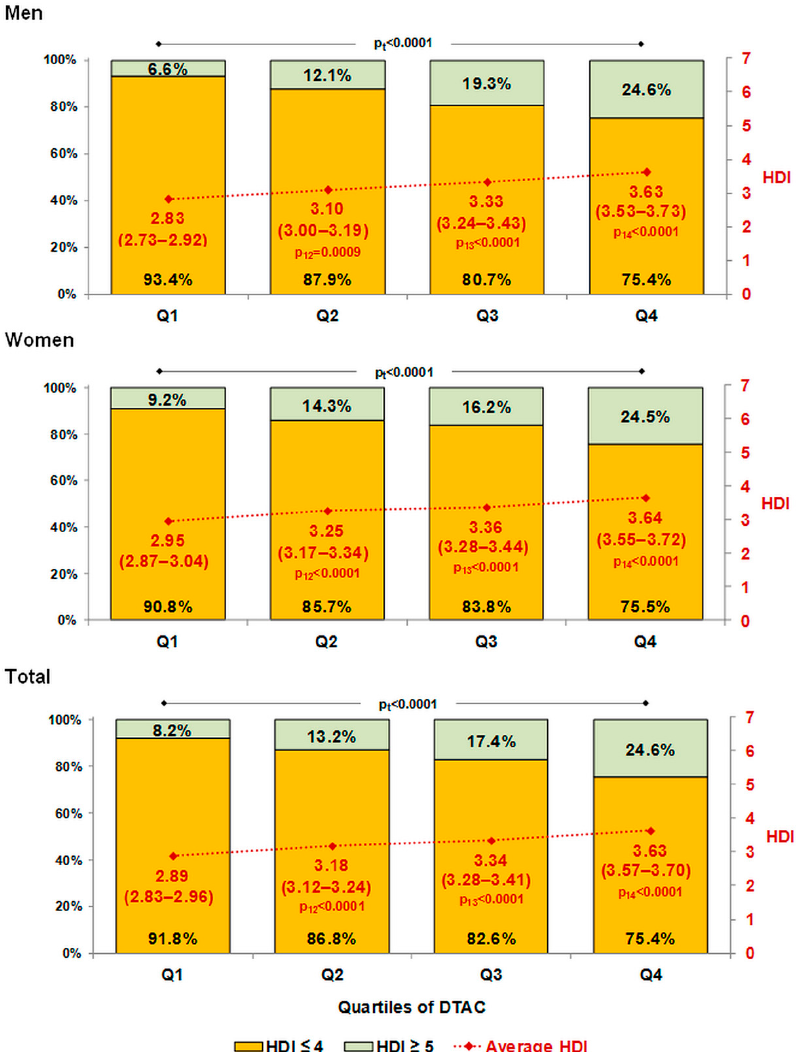
Figure 1. Distribution of HDI score (HDI ≥ 5 vs. HDI ≤ 4) and average HDI score (95% CI) by quartiles of DTAC. Mean HDI adjusted for age in men and women and additionally for sex in the total group. p t —p-value for trend test; p 12 , p 13 , and p 14 —p-values for comparisons with reference quartile Q1. DTAC—dietary total antioxidant capacity; HDI—Healthy Diet Indicator. Difference between average HDI was tested using a general linear model with Tukey–Kramer adjustment for multiple comparisons, while the distribution of HDI was tested by Cochran–Armitage test for trend.